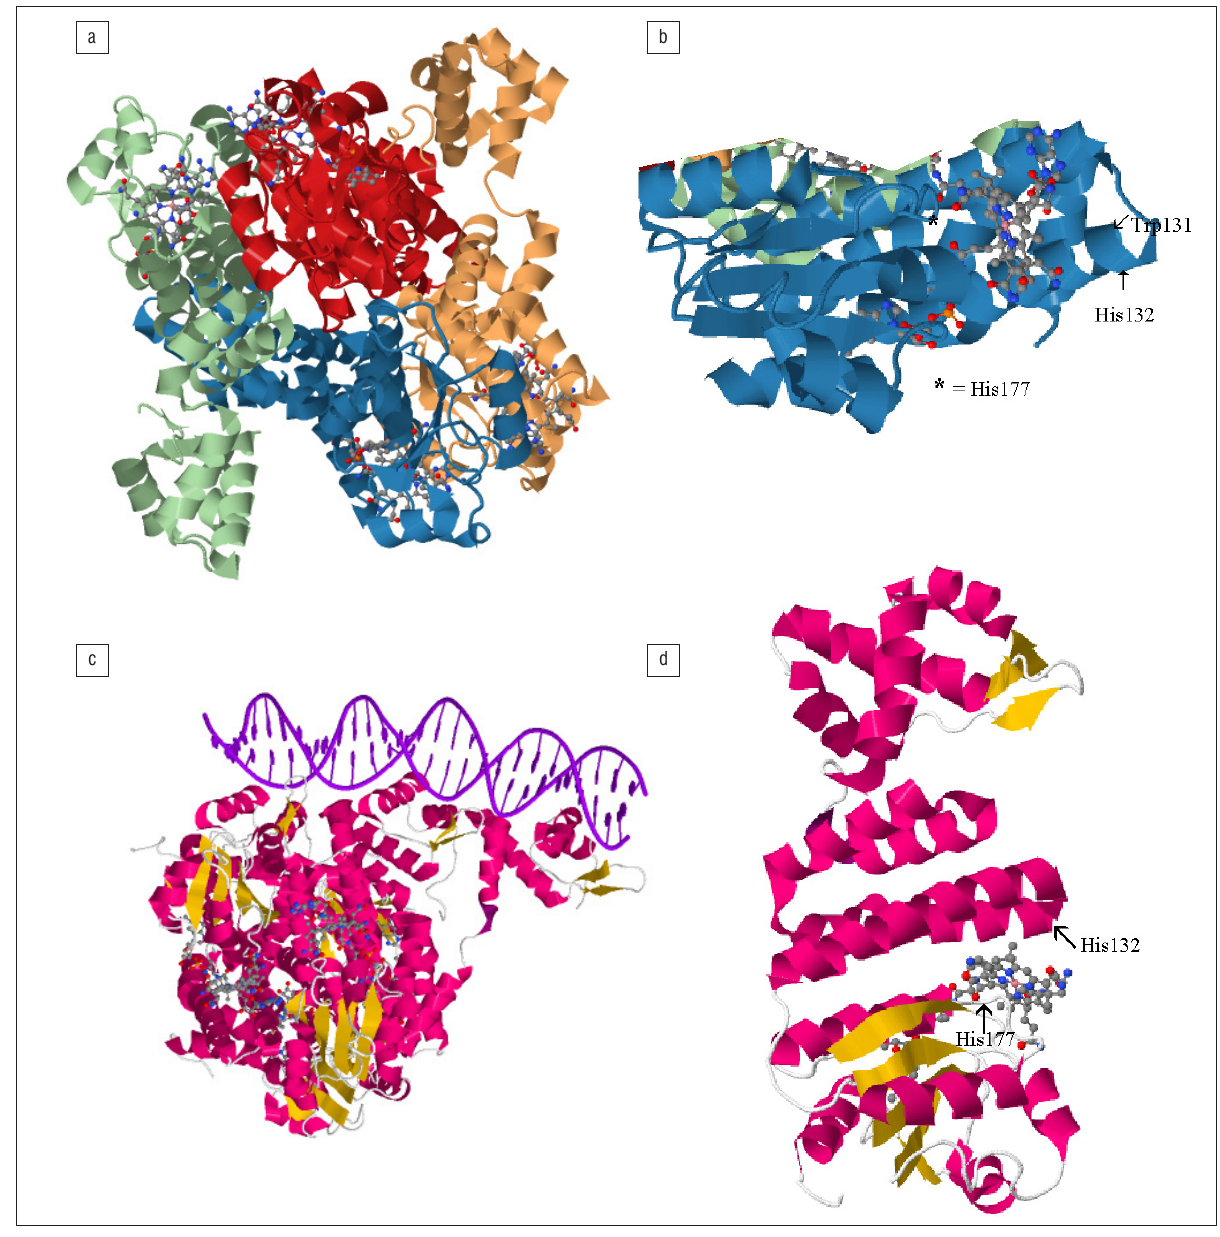
Figure 4: Structures of CarH. (a) CarH dark-state tetramer, showing the four identical subunits in four colours, and four molecules of AdoCbl (Co, coral; C, grey; N, blue; O, red; P, orange), one bound to each subunit (PDB ID: 5C8D). (b) CarH dark-state monomer, showing one of the four identical subunits (blue) and one molecule of AdoCbl (colours as in (a)). The truncated form of CarH (PDB ID: 5C8A), which consists of only the light- sensitive C terminal domain, is depicted in order to show the binding of AdoCbl more clearly. Trp131 and His132 are indicated by arrows and His177 by an asterisk. (c) CarH dark-state tetramer bound to 26 base pairs of the cognate DNA operator (DNA, purple; α helix, pink; β sheet, yellow; all other structures, white; colours of the AdoCbl molecules are as in (a)). The three DNA-binding domains, all facing in the same direction, can be seen at the bottom of the figure (PDB ID: 5C8E). (d) CarH light-state monomer (colours as in (c)). His132 and His177 are indicated by arrows and Trp 131 is behind His132 (PDB ID: